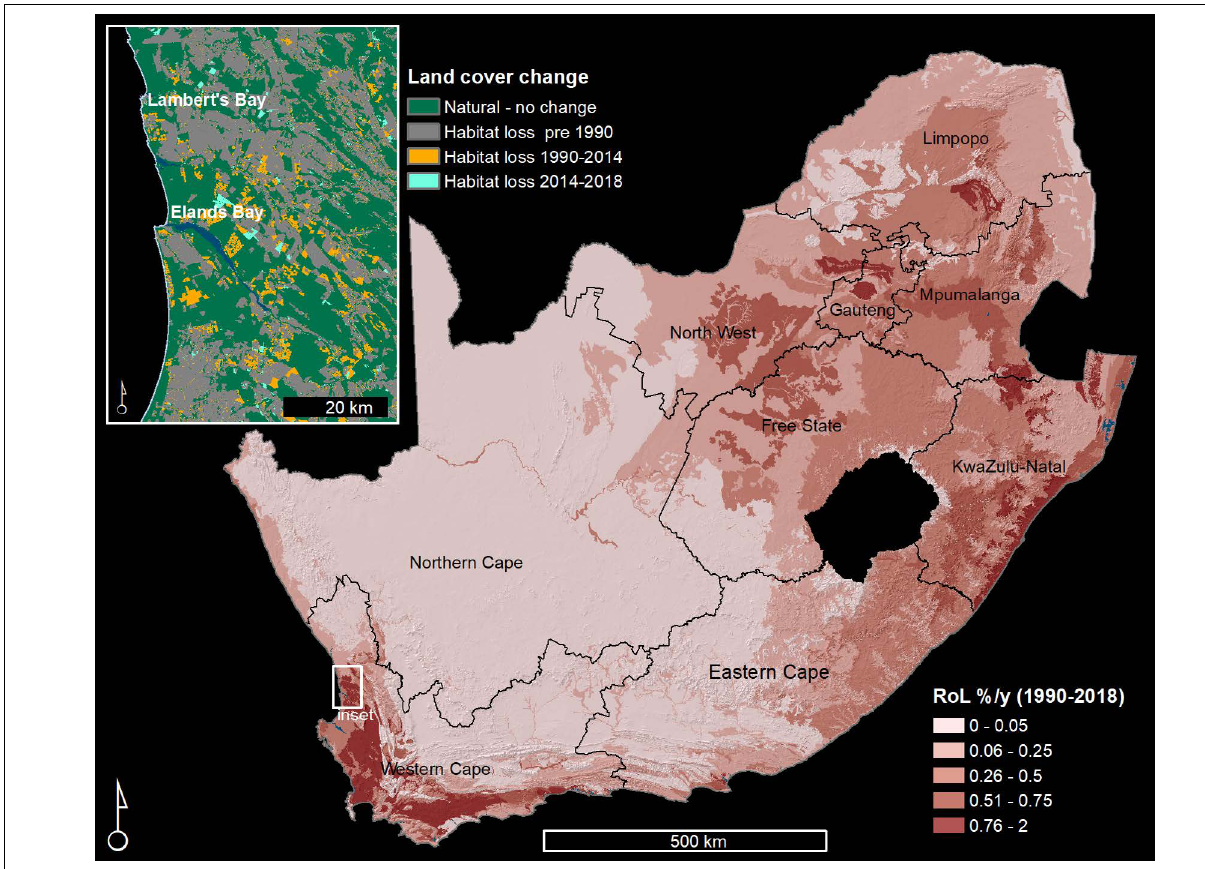
Rate of habitat loss indicator (RoL) for the period 1990–2018, calculated per terrestrial ecosystem type (vegetation types as defined by Mucina and Rutherford 13 ). The Cape lowlands, Mpumalanga Highveld grasslands and KwaZulu-Natal coast and adjacent interior had the highest rates of habitat loss between 1990 and 2018, with expanding croplands and human settlements being the key drivers. The inset map shows the land-cover change for a coastal portion of the Western Cape (known as the ‘Sandveld’) where cropland expansion has occurred during each time